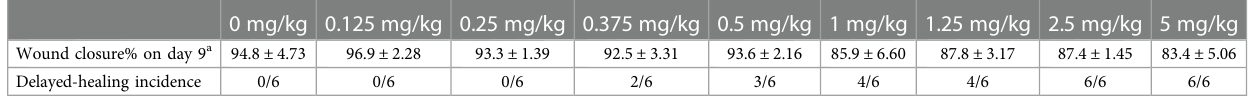
TABLE 1 Different doses of dexamethasone in normal mice (wound closure% on day